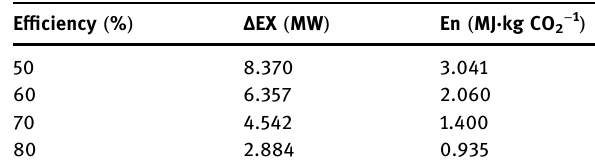
Table 5: Performance of DES + ERD at 10 atm and di ff erent